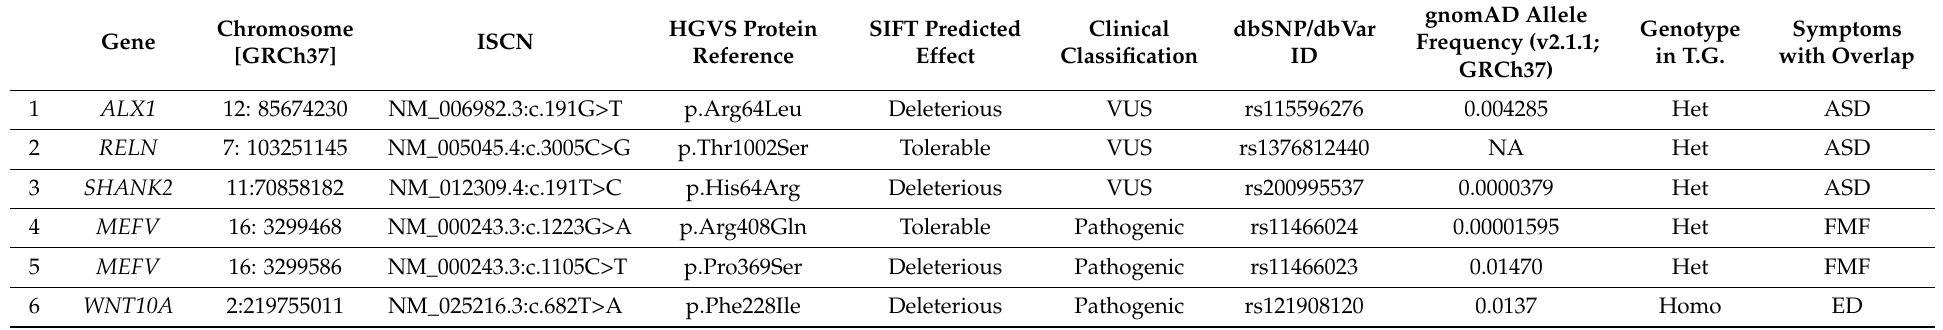
Table 2. Rare missense variants that are potentially relevant to T.G.’s phenotype, identified on both whole exome and whole genome